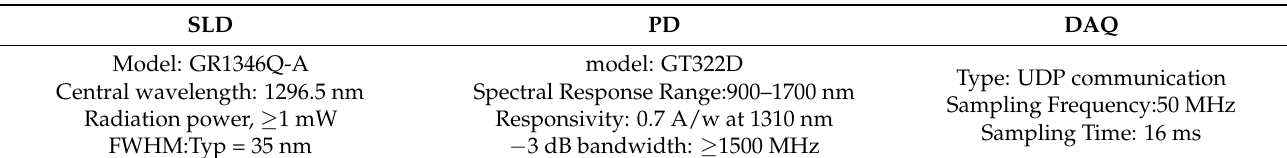
Table 1. The main parameters of the experiment setup.